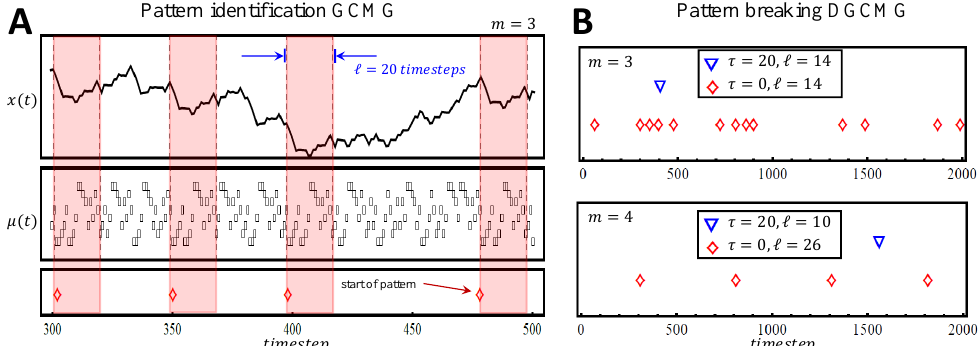
Figure 7. ( A ) Dynamical patterns in the GCMG for the case of m = 3. Top panel shows the price ( x ( t ) ), middle panel shows the global information ( µ ( t ) ) and the bottom panel uses diamonds to signal the start of a dynamical pattern. The 20 timestep length patterns are highlighted by the red shaded region; ( B ) Pattern breaking effect of latency for m = 3 (top) and m = 4 (bottom). Symbols represent pattern appearances of a given length (cid:96) , for a delay τ